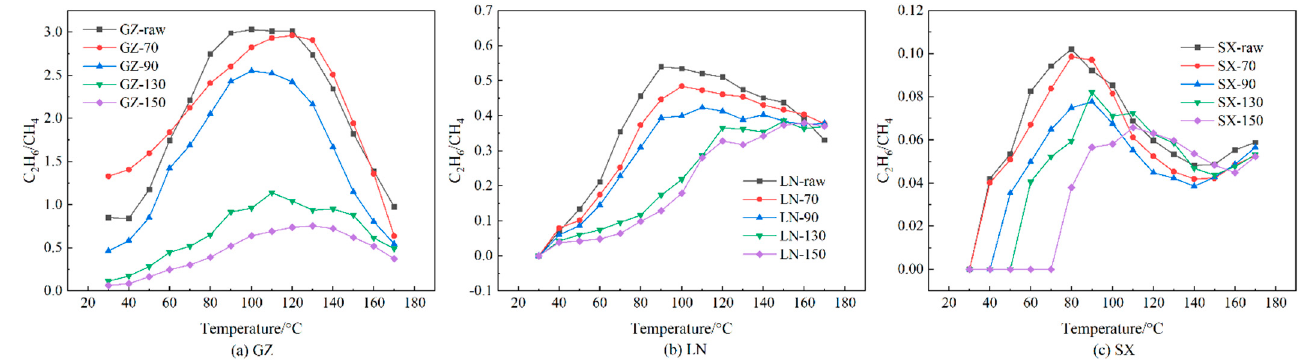
Figure 7. Alkane ratio during temperature programming: (a) GZ; (b) LN; (c) SX.